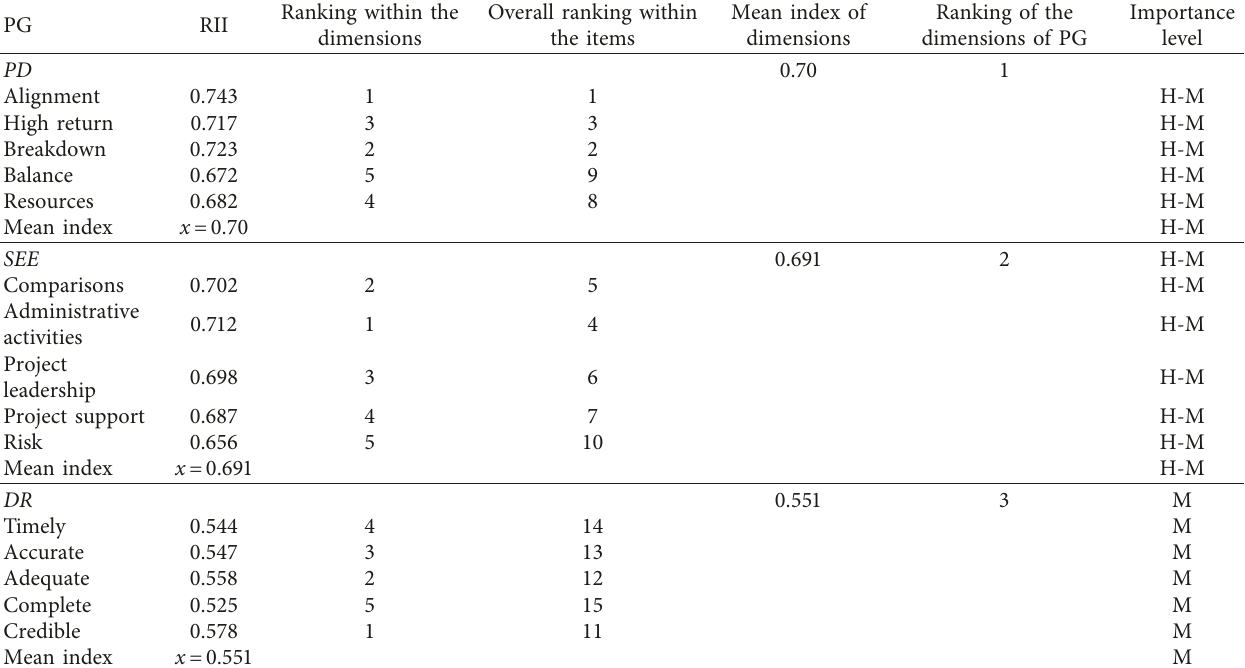
Table 5: Ranking of PG practices.